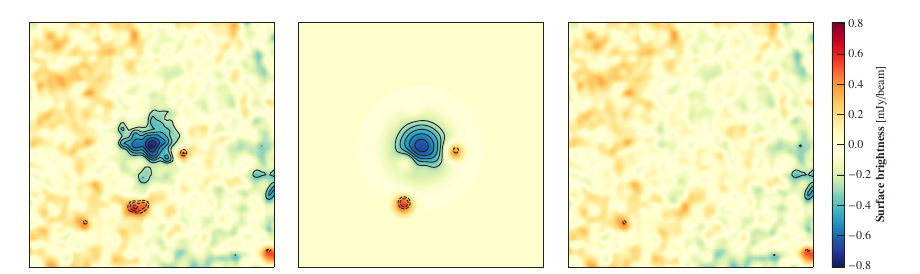
Figure 3. Results of the fit of the 150 GHz map of ACT-CL J0215.4 + 0030. From left to right, we present the data, the best-fitting model (including the Gaussian models of accounted point sources), and the residuals. Each map is given in the same 5’ 10” gaussian kernel for display purposes. In each map, the contours give the SNR levels starting from Figure 2. Results of the estimation of the contamination in the NIKA2 150 GHz map for one of the 3 σ with a 1 σ sources in our field. Left: SED results. The NIKA2 150 GHz point is extrapolated from the fit by ± integrating the SED distribution in the NIKA2 150 GHz bandpass. The black line marks the best-fitting SED, and the enveloppes show the 1 and 2 σ confidence intervals. Right: inferred probability distribution for the 150 GHz flux of the same source. The vertical line shows the flux computed from the best-fitting SED.